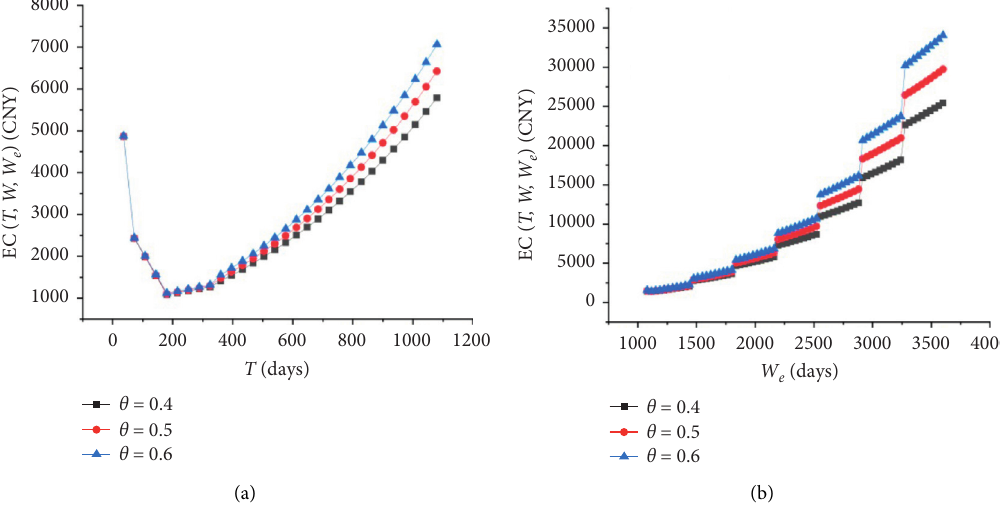
Figure 8: EW cost change with failure influence coefficient θ when W